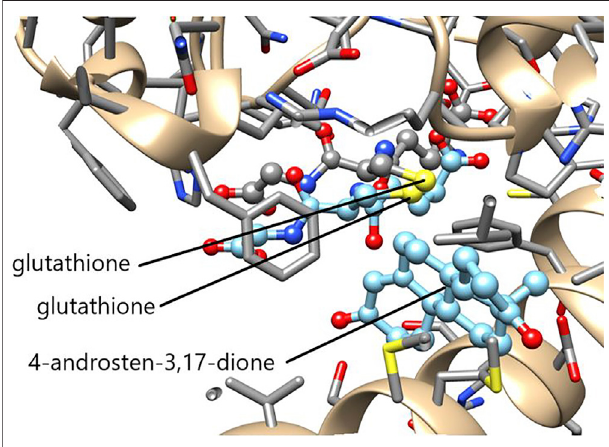
FIGURE9| SuperimposedactivesitesofGSTE14fromD.melanogaster and HsaGST A3-3. The crystal structures of GSTE14 (PBD ID: 6t2t) and HsaGST A3-3 (PDB ID: 2vcv) were matched in Chimera (Pettersen et al., 2004). The aminoacid residues of GSTE14 are rendered in gray sticks and thebound glutathione coloredby element. Theligands glutathioneand 4- androsten-3,17-dione in light blue are the only structures shown from HsaGST A3-3. Note the similar locations of the reactive sulfur (yellow) of glutathione near the scissile bonds of the steroid in the two